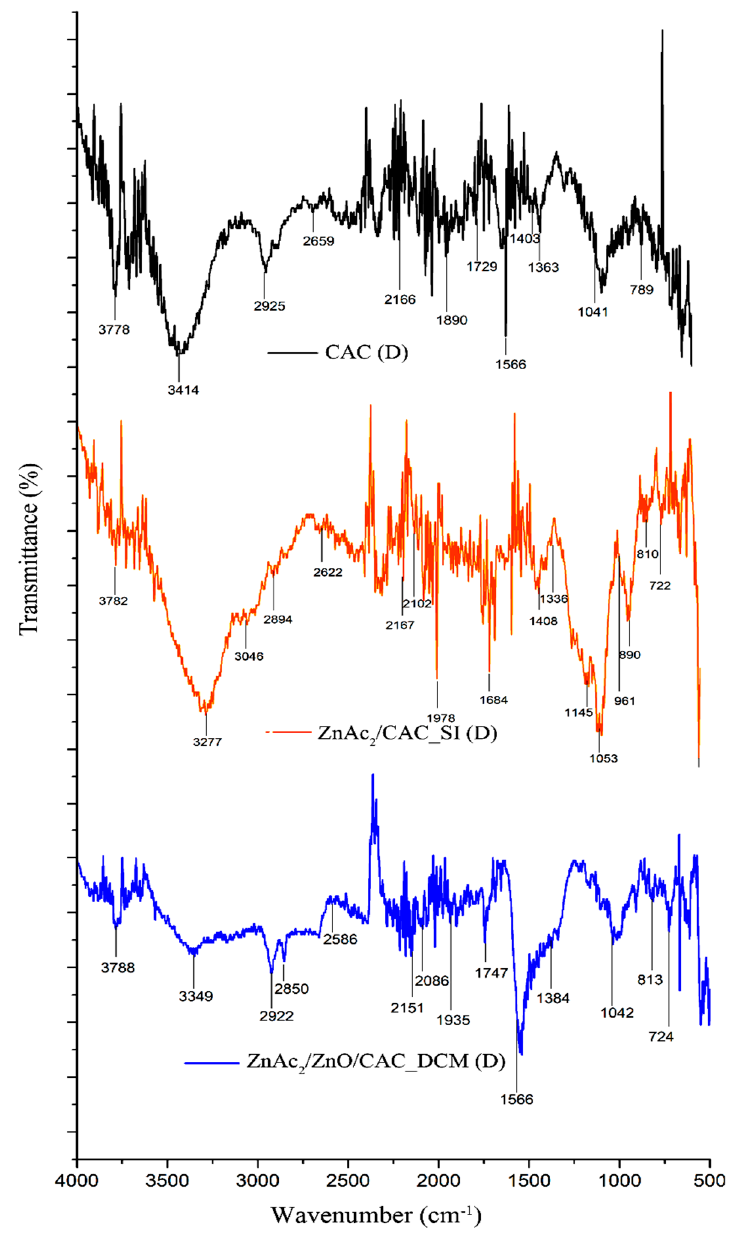
Figure 12. FTIR spectra for selected exhausted adsorbents (raw CAC, ZnAc 2 /CAC_SI, and ZnAc 2 /ZnO/CAC_DCM) at 150 °C desorption operating temperature.